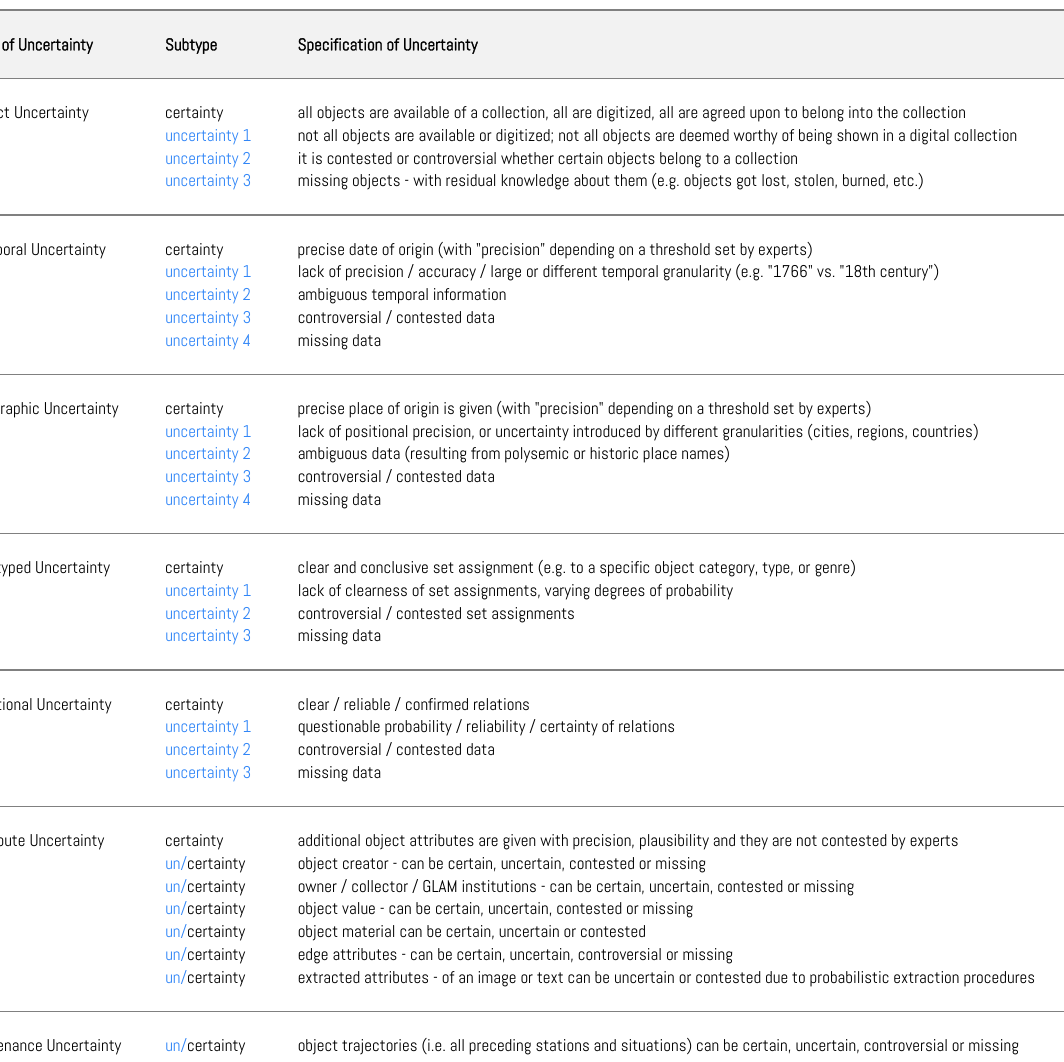
Figure 2. Frequent types of uncertainty in cultural object